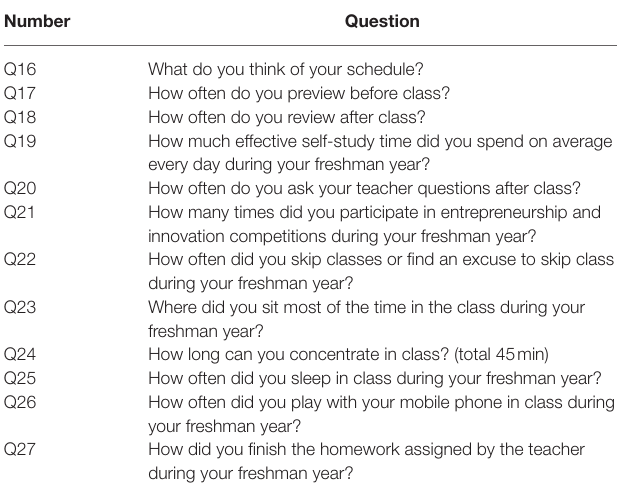
TABLE 6 | Questions about learning participation